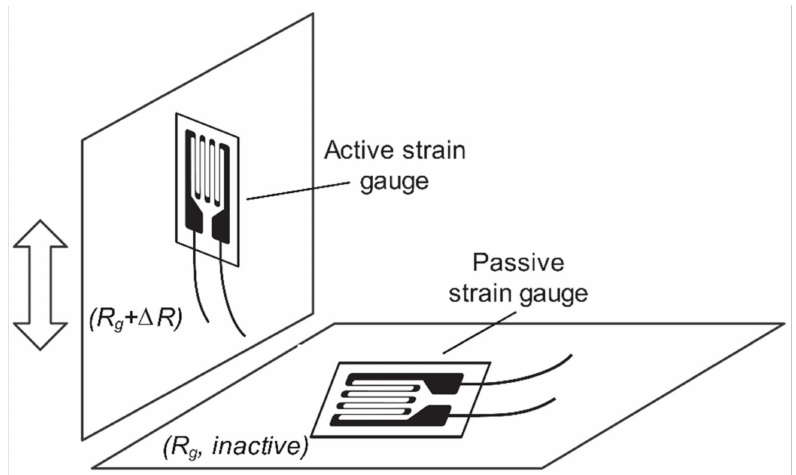
Figure 4. Configuration placement of active and passive strain